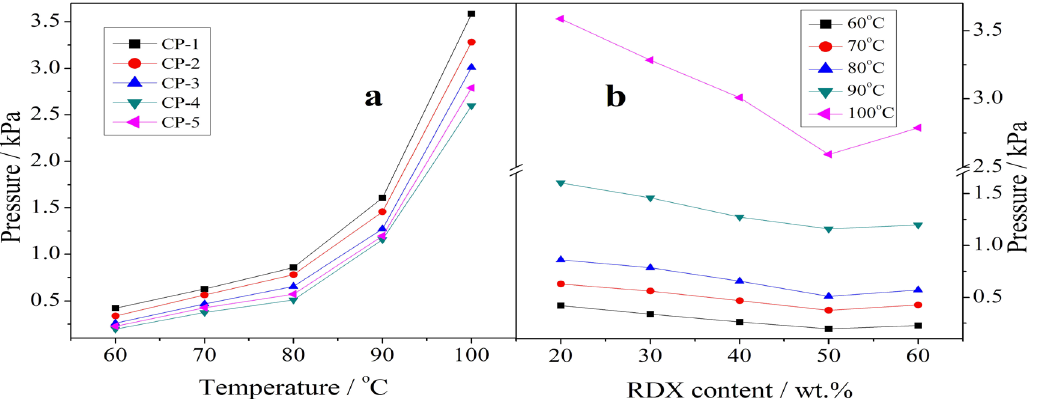
Figure 2. Curves of thermal decomposition gas pressure vs. temperature (a) and RDX content